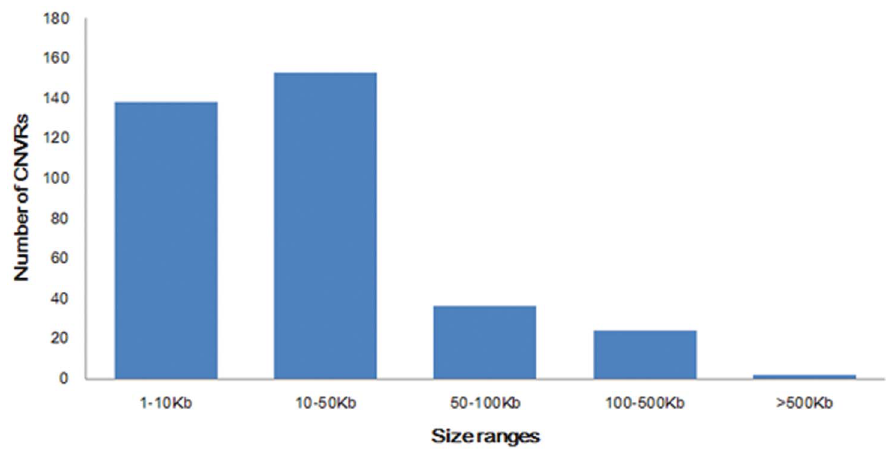
Figure 5. Size range distribution of the CNVRs detected.